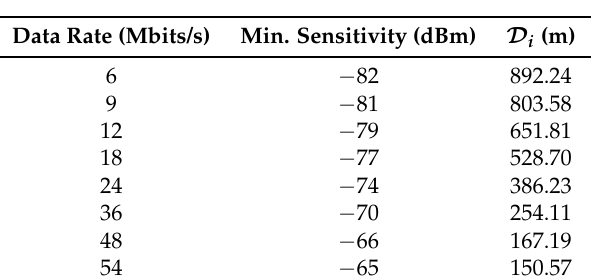
Table 2. Maximum achievable distance of each transmission mode based on the minimum sensitivity of the receiver antenna.